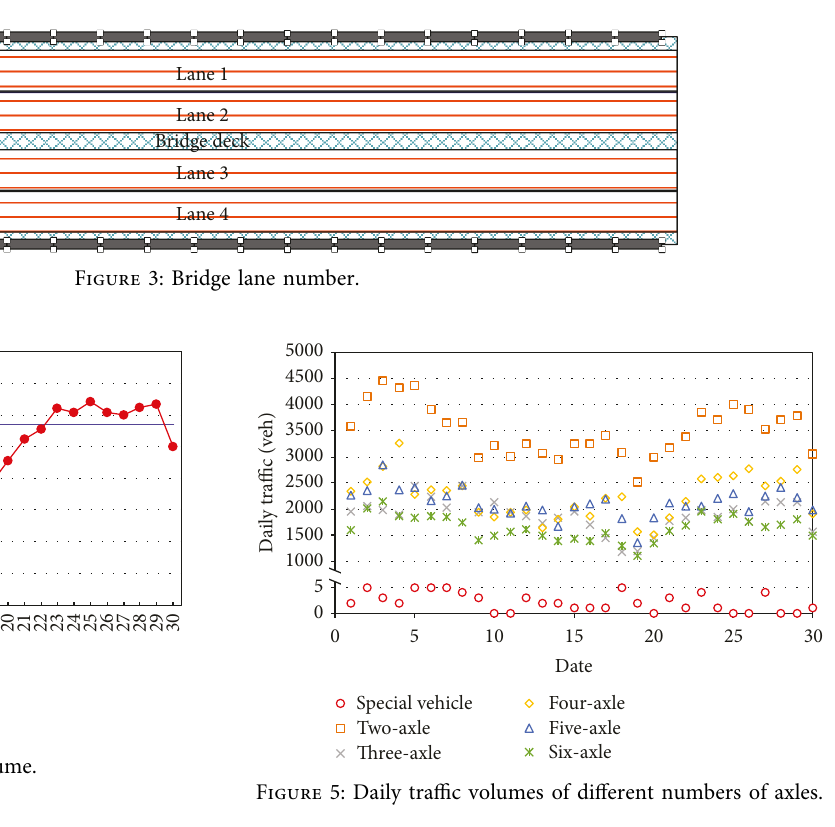
Figure 5: Daily traffic volumes of different numbers of